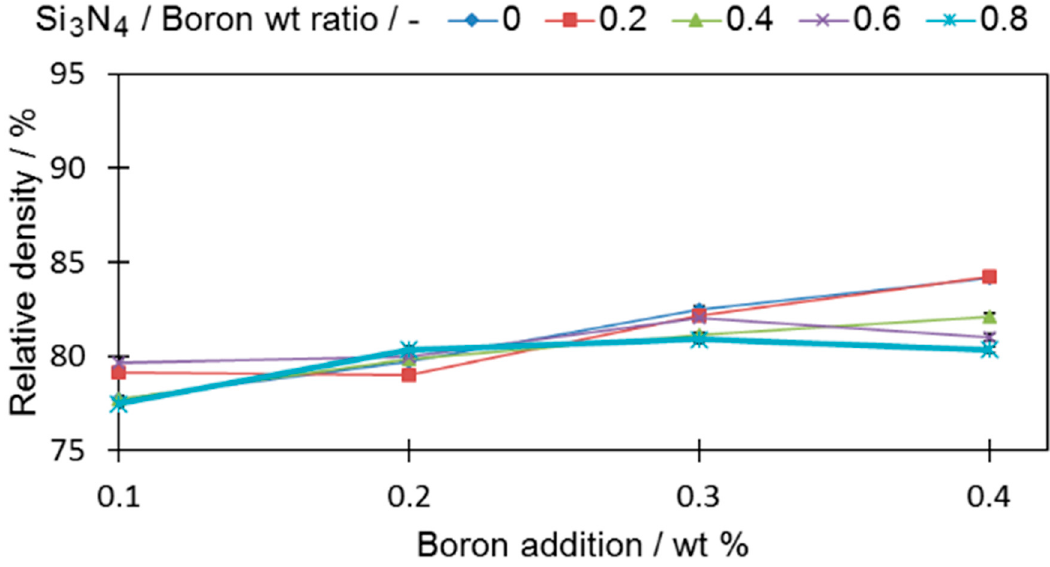
Figure 10. Density change of prismatic samples in the boron and silicon nitride addition functions. Numerical data are available in Table S5 in the Supplementary Material.